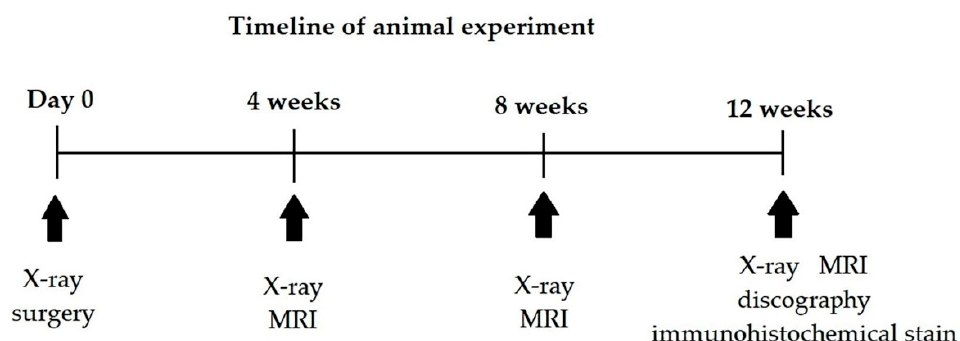
Figure 1. Timeline of animal